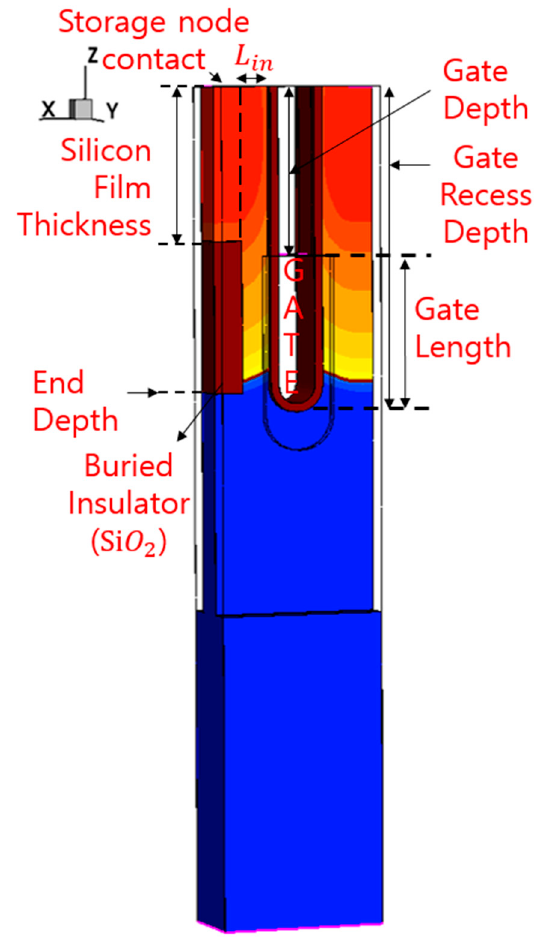
Figure 1. 3D structure of a partial isolation type buried channel array transistor (Pi-BCAT).